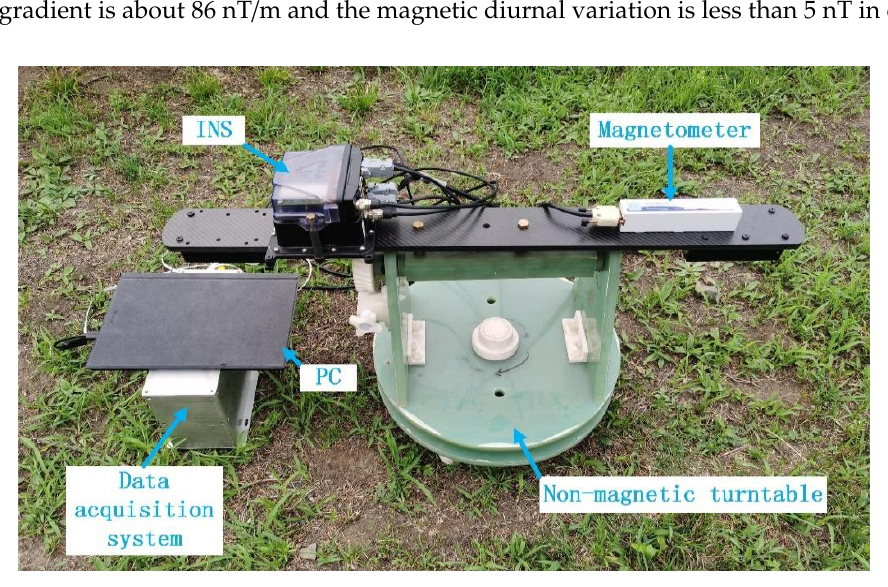
Figure 6. Diagram of experimental system.